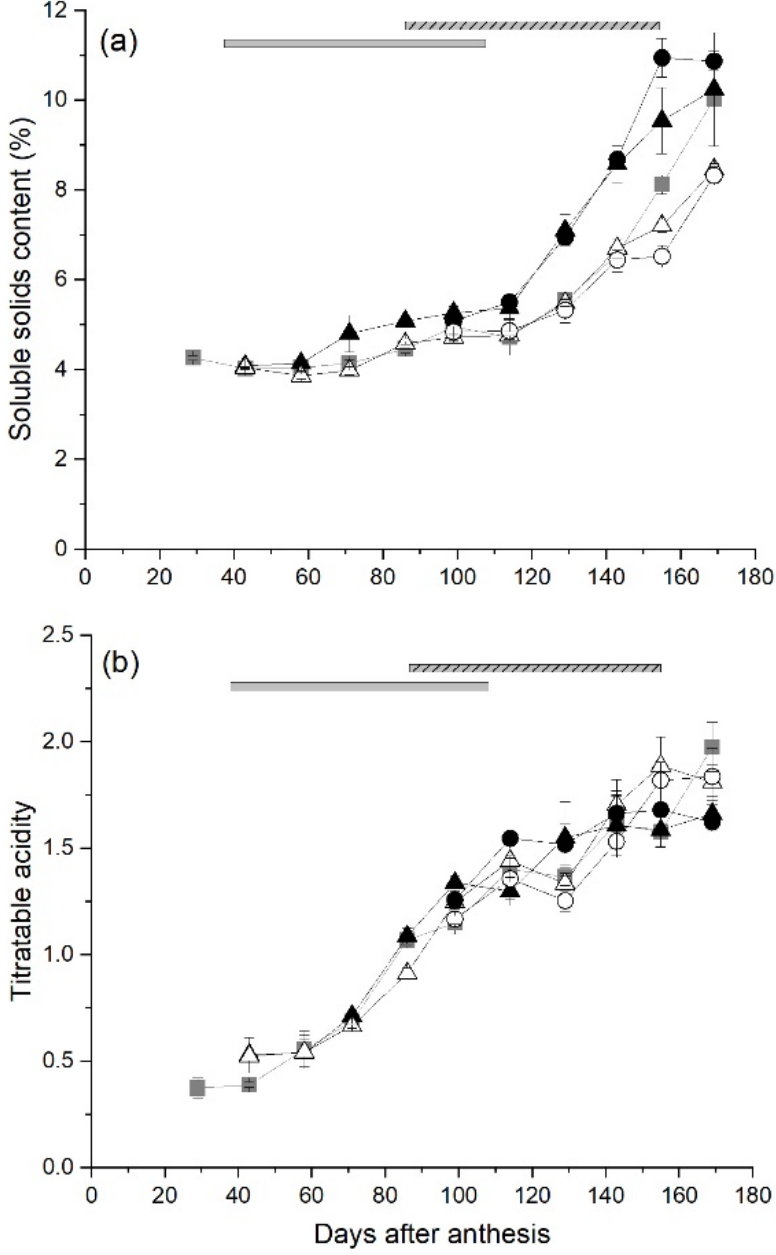
Figure 5. The effect of time of manipulation of carbohydrate supply together with phloem girdling on ( a ) soluble solids content and ( b ) titratable acidity of Actinidia chinensis var. chinensis ‘Zesy002’ kiwifruit during development. Data are shown for fruit from ungirdled control canes ( (cid:4) ), Early girdled canes with High ( (cid:78) ) or Low ( (cid:52) ) carbohydrate supply or Late girdled canes with High ( • ) or Low ( ) carbohydrate supply. Early treatments were applied at 38 days after anthesis with the (cid:35) duration of the open girdle shown by the grey solid bar at the top of each panel. Late treatments were applied at 86 days after anthesis with the duration of the open girdle shown by the grey/black stripped bar at the top of each panel. High carbohydrate supply treatments had six leaves per fruit, while low carbohydrate supply treatments had one or two leaves per fruit. Data are means ± SEM, n =